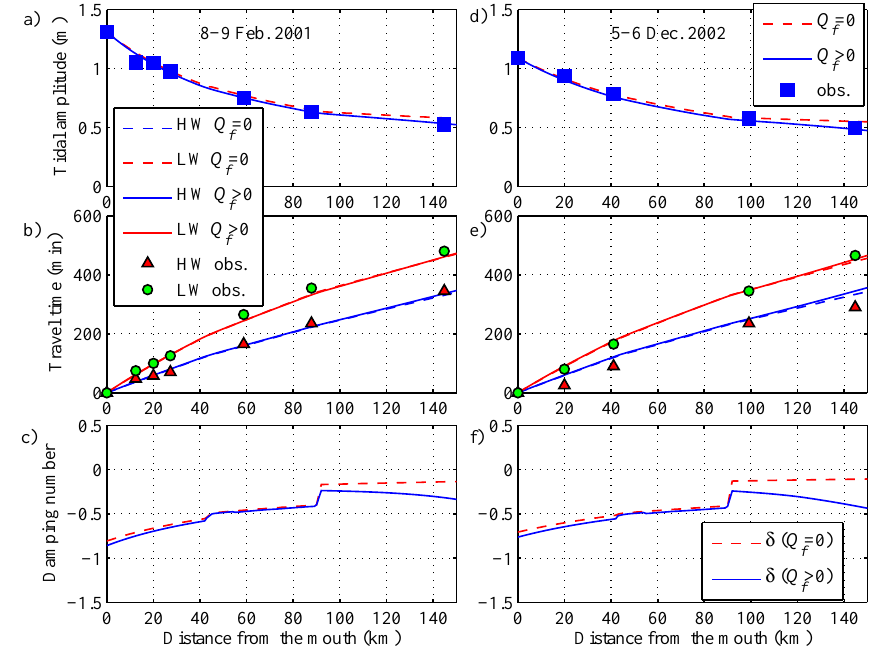
Fig. 9. Comparison of analytically calculated tidal amplitude (a, d) , travel time (b, e) with measurements and comparison of two analytical models to compute the dimensionless damping number (c, f) on 8–9 February 2001 (calibration) and 5–6 December 2002 (validation) in the Modaomen estuary. The dashed line represents the model where river discharge is neglected. The continuous line represents the model accounting for the effect of river discharge. Both models used the same friction coefficients calibrated while considering river